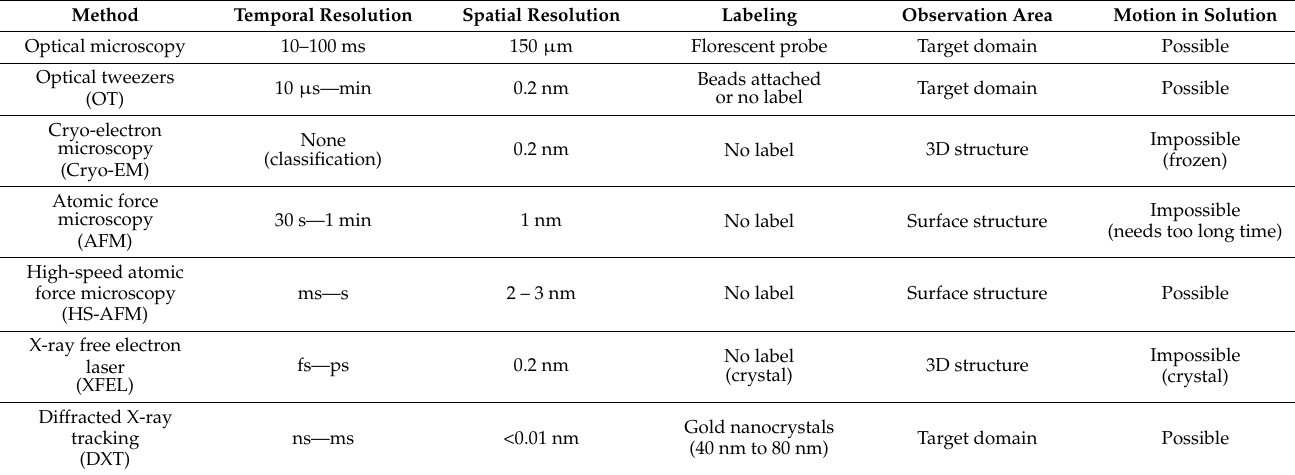
Table 1. Summary of methods for visualizing membrane protein dynamics discussed in this